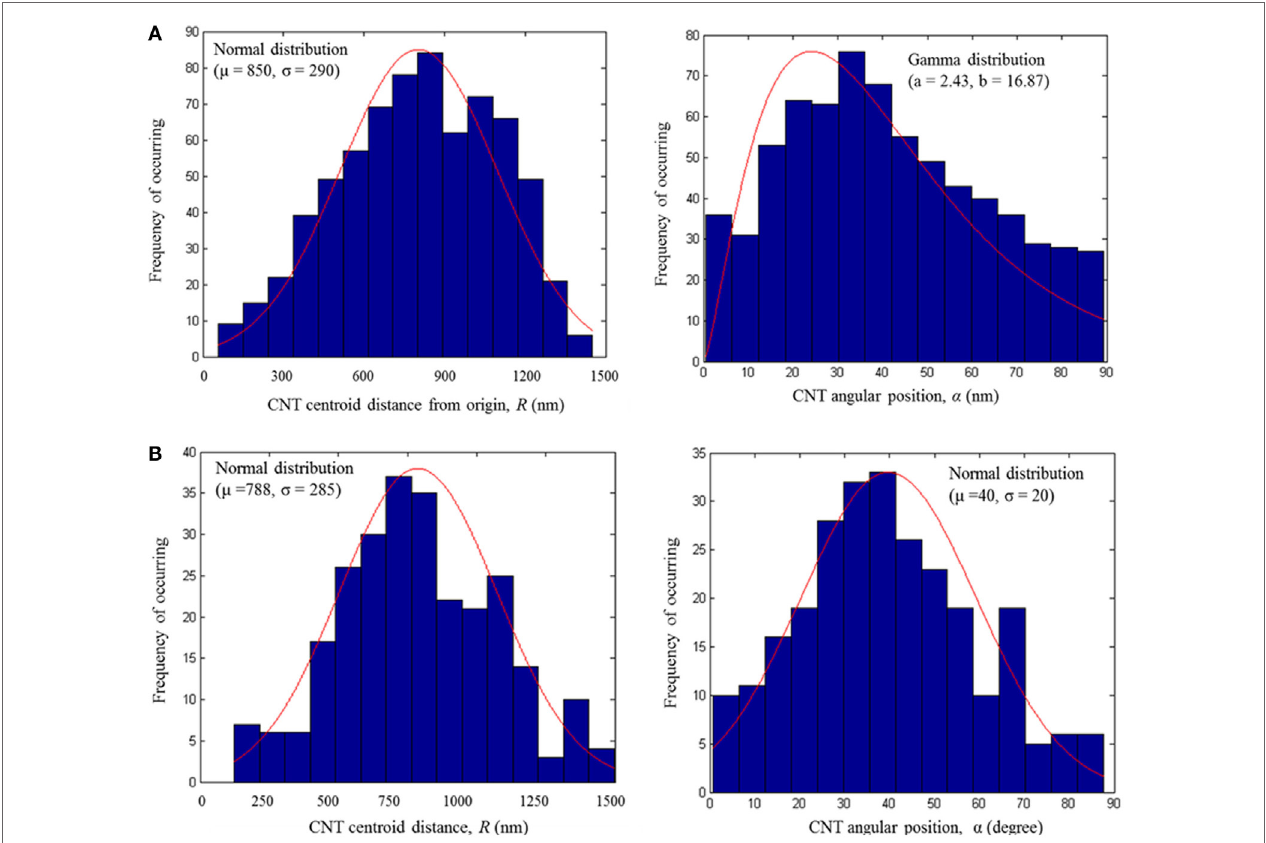
FigUre 9 | cnT spatial distribution within the PP matrix as extracted from the seM micrographs of (a) 4 wt% cnT/PP bulk composites; (B) 3 wt% cnT/PP fiber